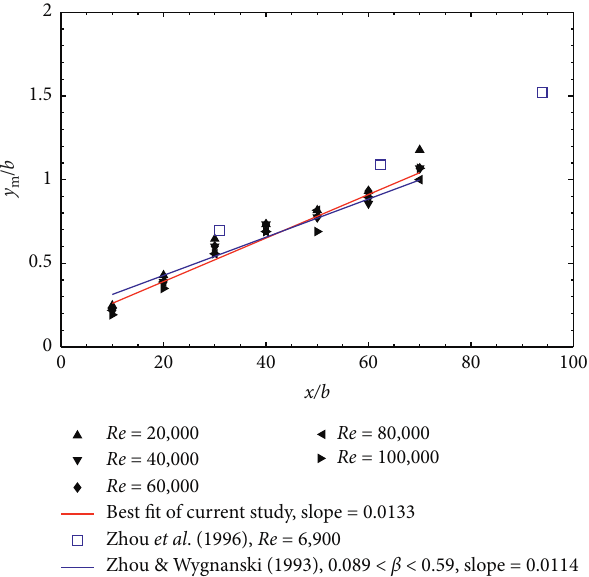
Figure 10: Rate of spread of y m for various Reynolds